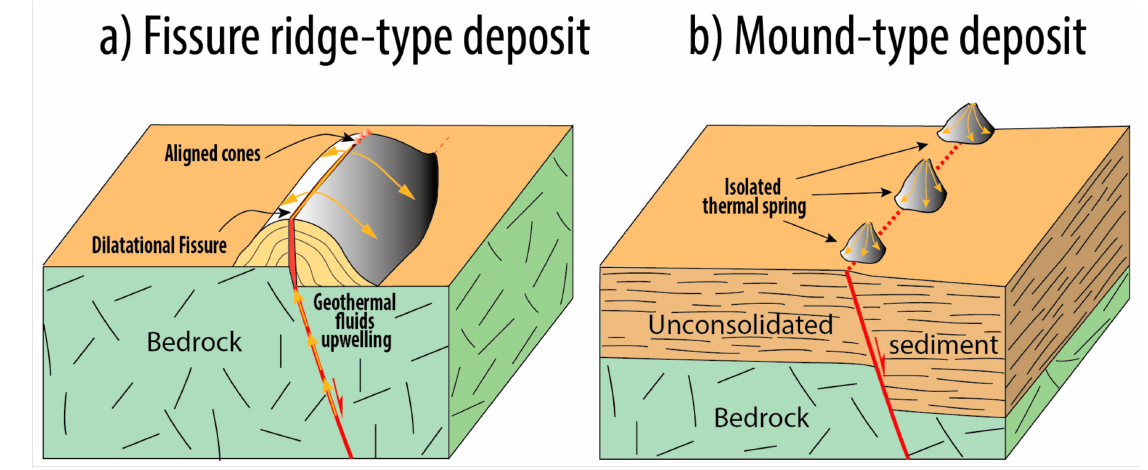
Figure 6. Diagram showing the geological setting favoring the formation of the fissure ridge ( a ) and mound-type ( b ) travertine deposits. See the text for more